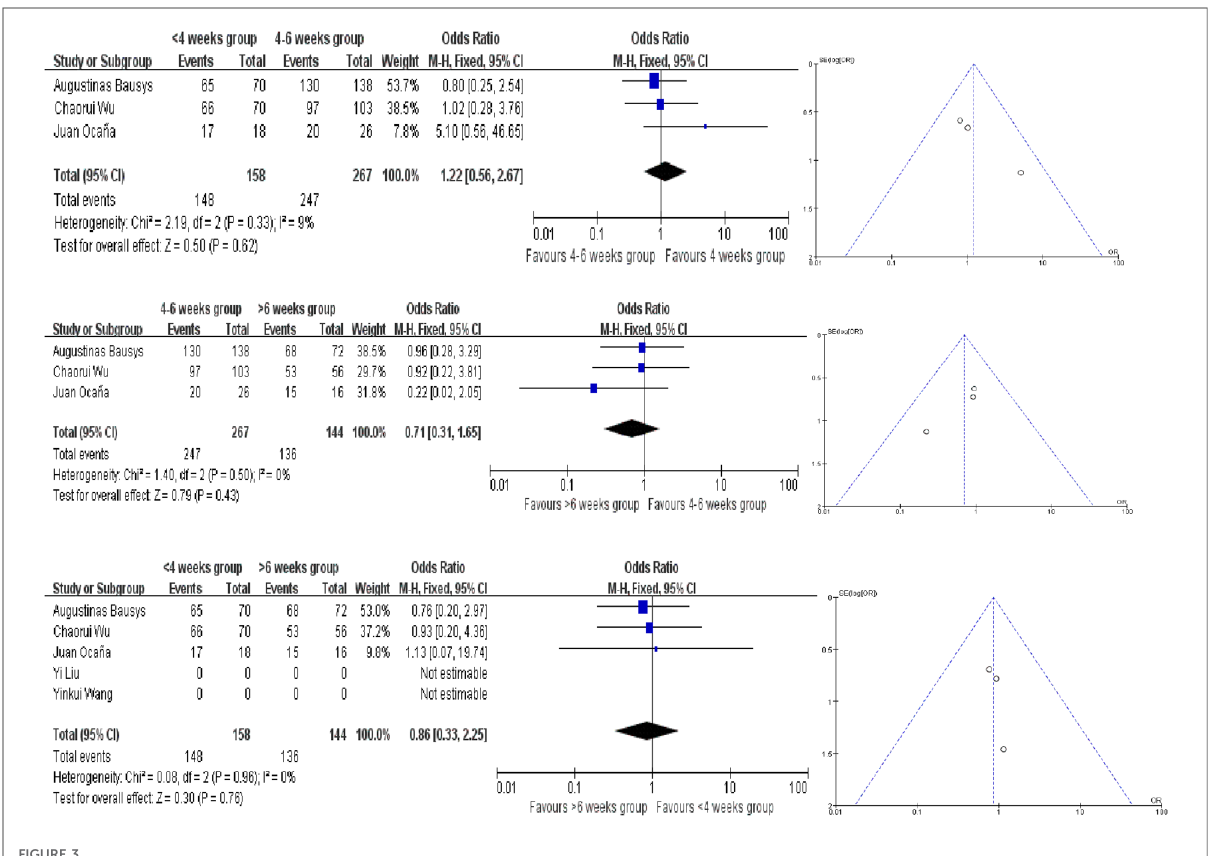
FIGURE 3 Forest plot and funnel plot for R0 resection rates meta